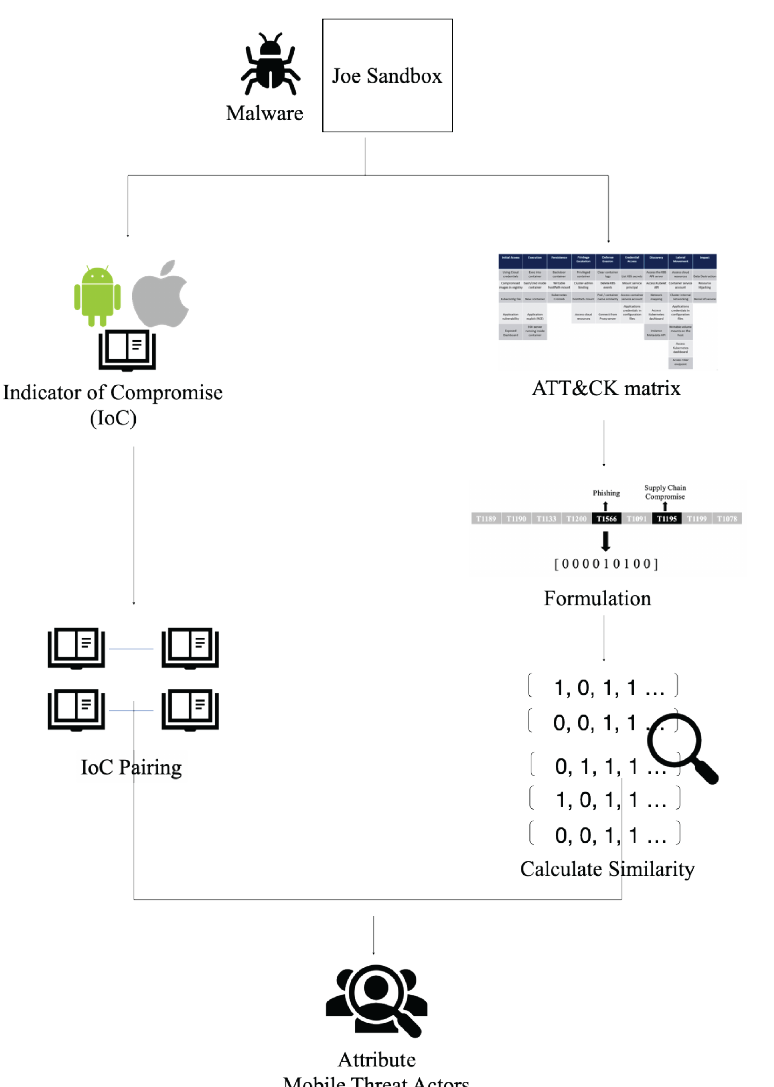
Figure 2. The methodology proposed in this study consists of two parts. The two parts are the mathematical modeling of ATT&CK matrix and IoC